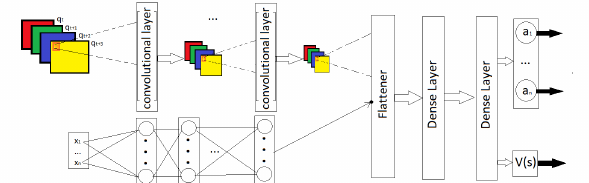
Figure 3. The general architecture for training agents with intrinsic motiva- tions. ( q t , q t +1 , ..., q t + k − 1 ) of k images captured by the agent’s